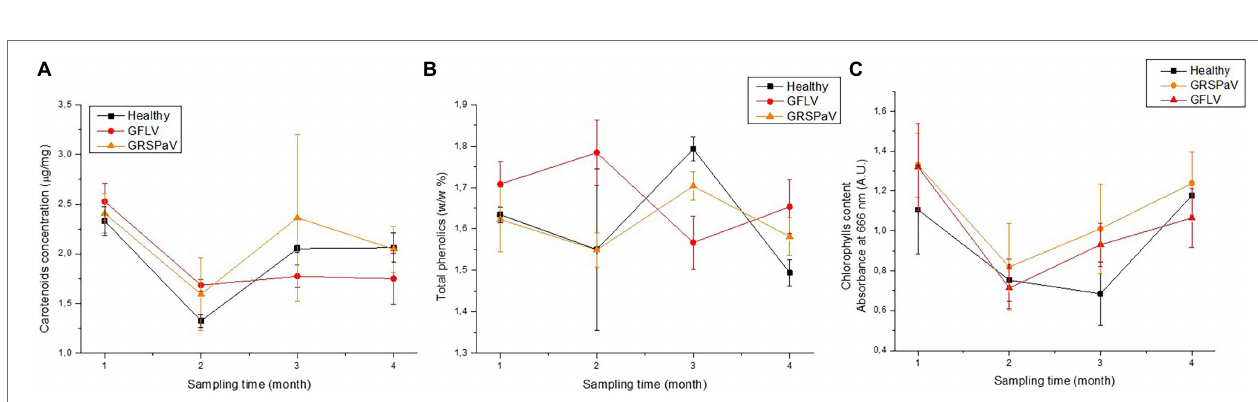
FIGURE 6 | Accumulation of (A) carotenoid, (B) phenolic, and (C) chlorophyll compounds in healthy and infected grapevine leaf samples, during the vegetative season. The values reported are mean ± SE of the classes of compounds obtained from four independent biological samples ( n =